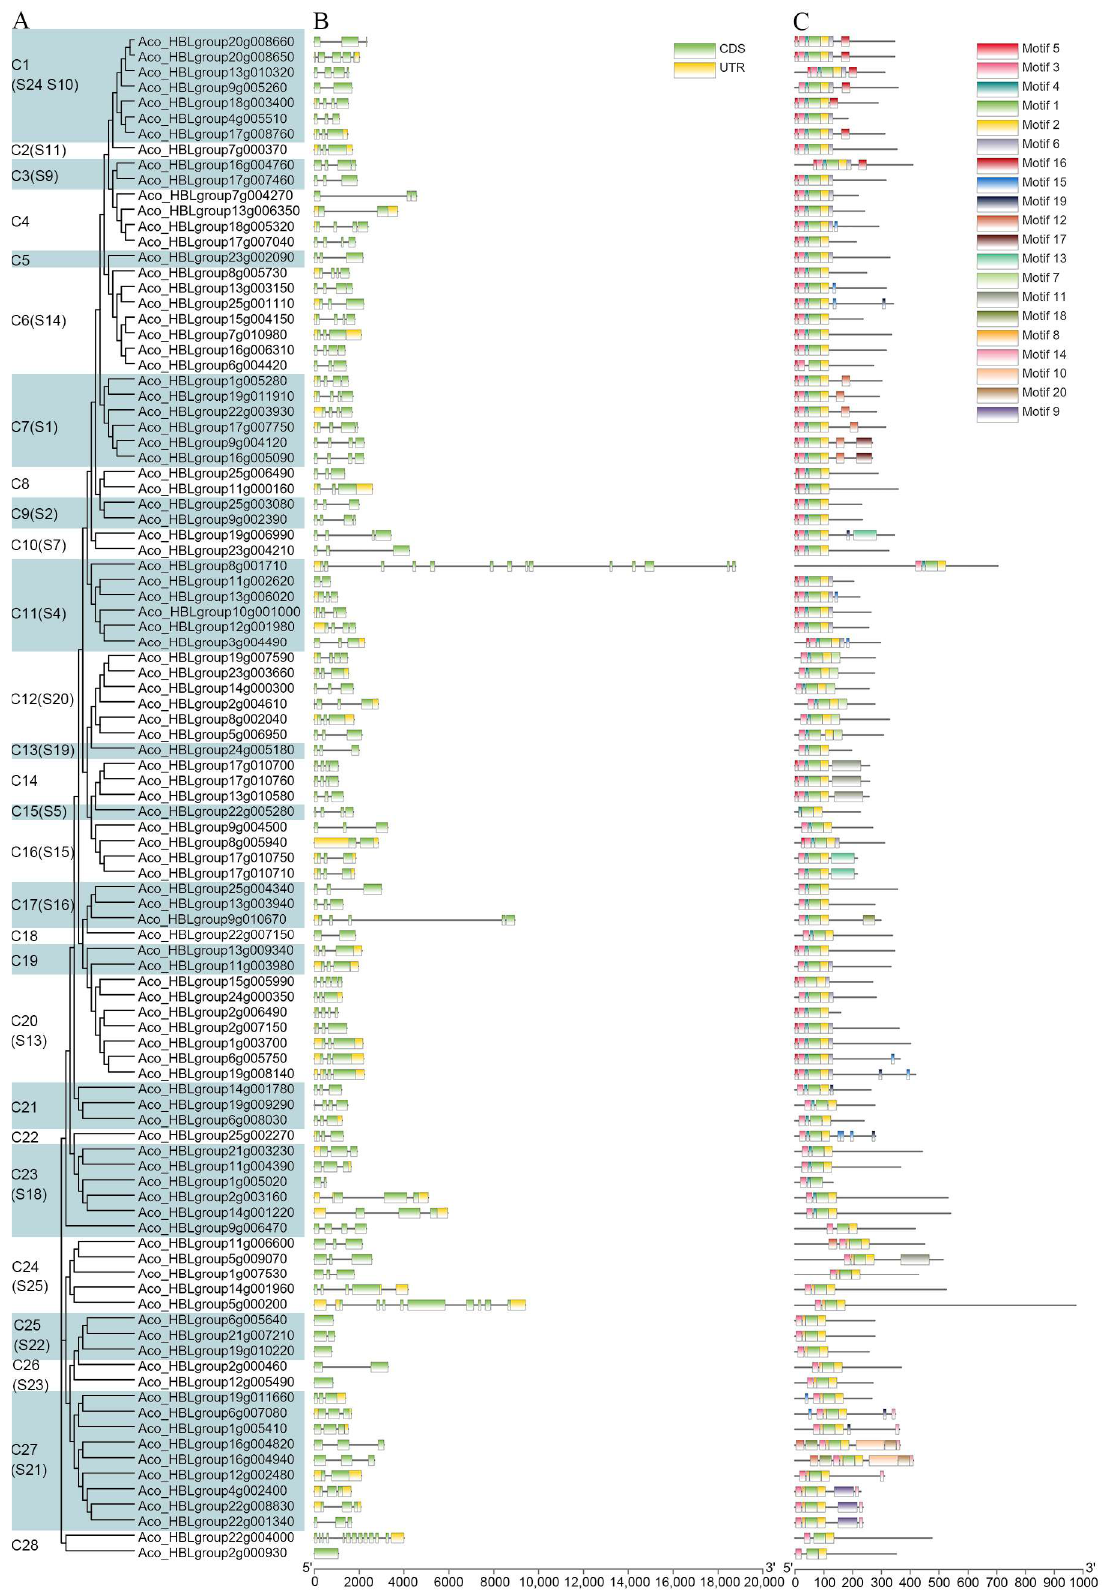
Figure 2. The motif composition and gene structure of AbR2R3-MYB gene family. ( A ) The neighbor- joining tree of 99 AbR2R3-MYB proteins. ( B ) Exon/intron structures of the R2R3- MYB genes. Yellow boxes, UTR; green boxes, exons; space between the boxes, introns. ( C ) The conserved motifs in the AbR2R3-MYB TFs were predicted using the MEME Suite web server.